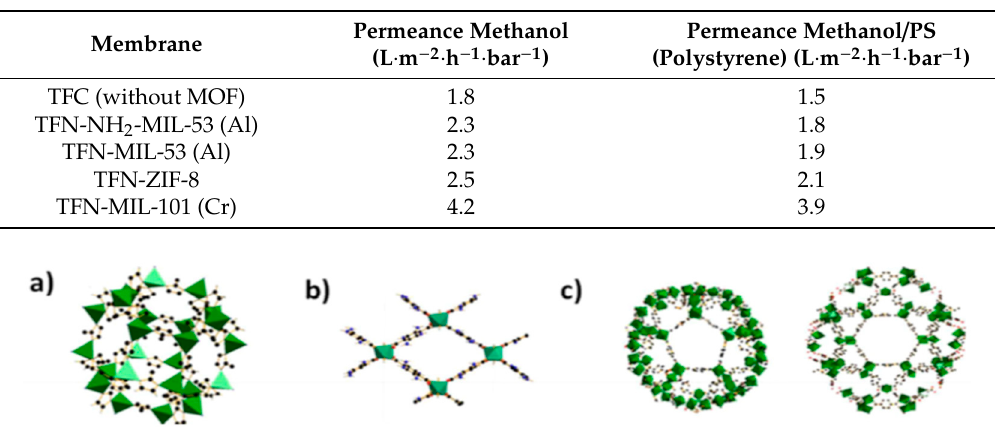
Figure 4. ( a ) Building blocks of ZIF-8 with ZnN 4 ; ( b ) pore system in NH 2 -MIL-53 with AlO 6 ; ( c ) building blocks of MIL-101 with mesoporous cages; Reproduced with permission from [63].